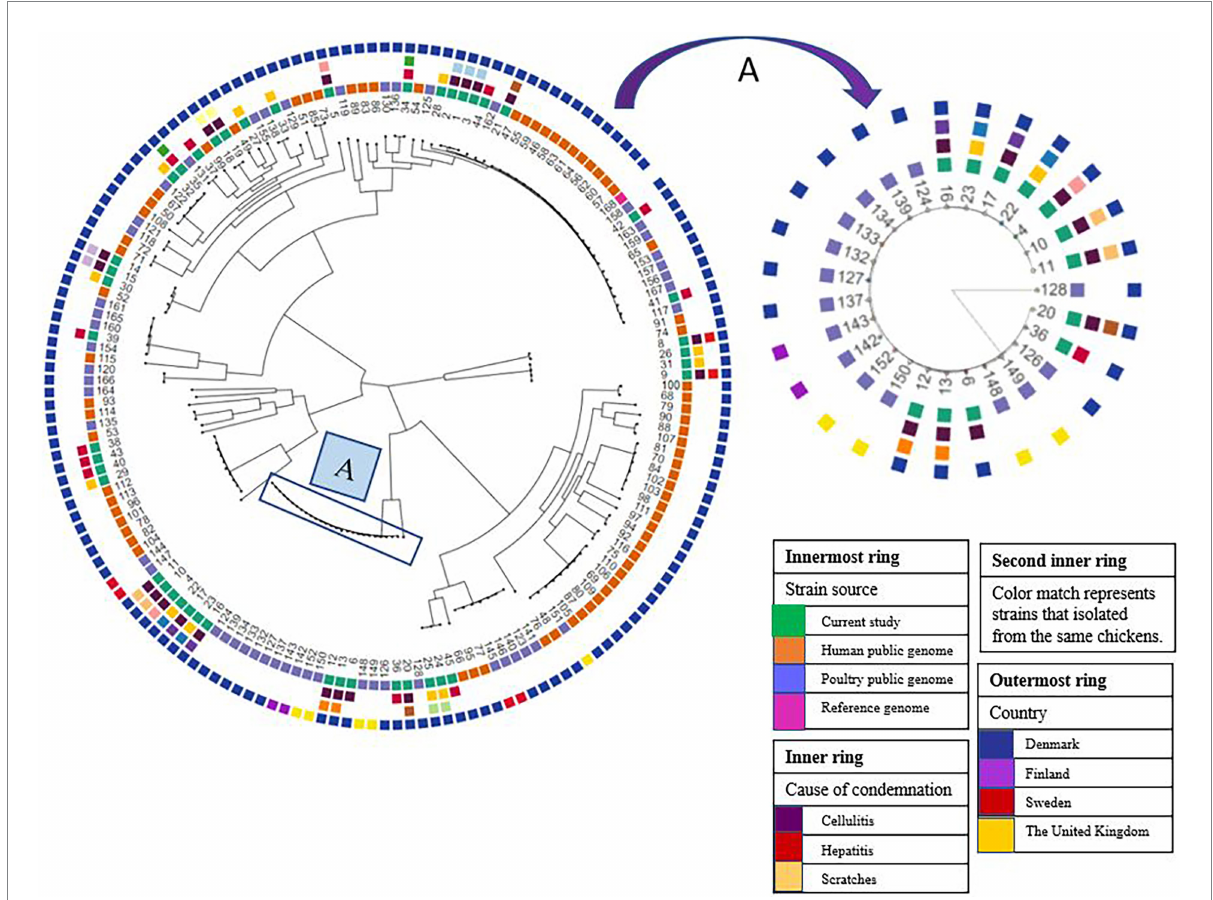
FIGURE 2 Phylogeny of E . coli isolated from broiler carcasses condemned with cellulitis, scratches, and hepatitis. Sample IDs from 1–45 represent samples from this study, whereas public genomes indicated with ID from 46–116. (A) Represents the major E . coli clade of 12 isolates (11, 10, 4, 22, 17, 23, 16, 12, 13, 6, 36, 20) all belong to ST117 mainly obtained from carcasses condemned with cellulitis. The isolates in this clade clustered together with isolates originating from poultry with cellulitis/colibacillosis in Denmark, Finland, and United